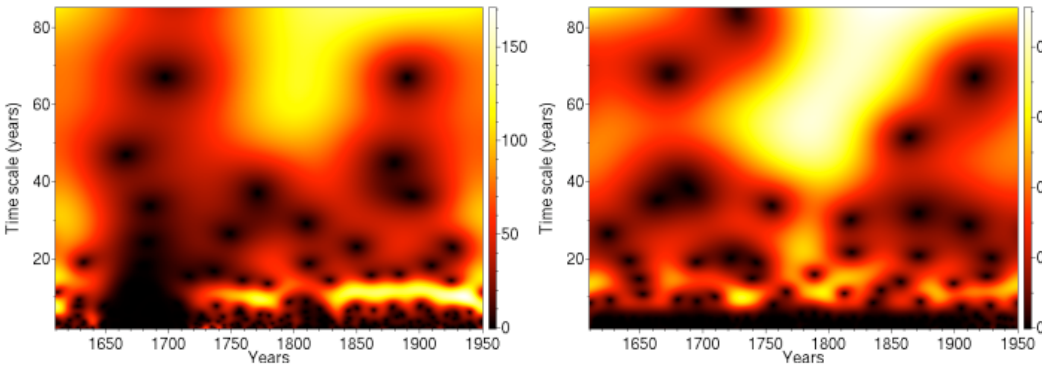
4 Periodicities in 14 C production rate longer than 22